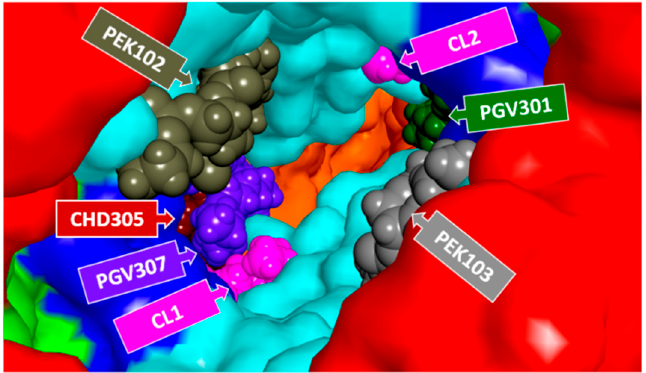
Figure 3. Visualization of hydrophobic molecules bound in the intermonomer cavity of CcO (PDB structure 5B1A [12]) probably as a part of crystallization solvent. CPK visualization of PGV ((1 R )-2-{[{[(2 S